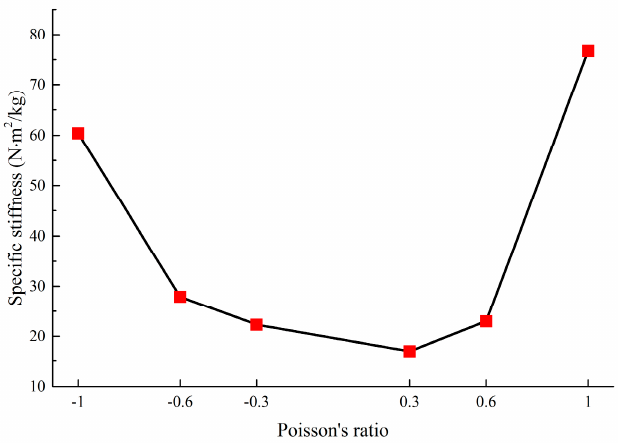
Figure 11. Specific stiffness (deformation resistance) of metamaterials with various PR.